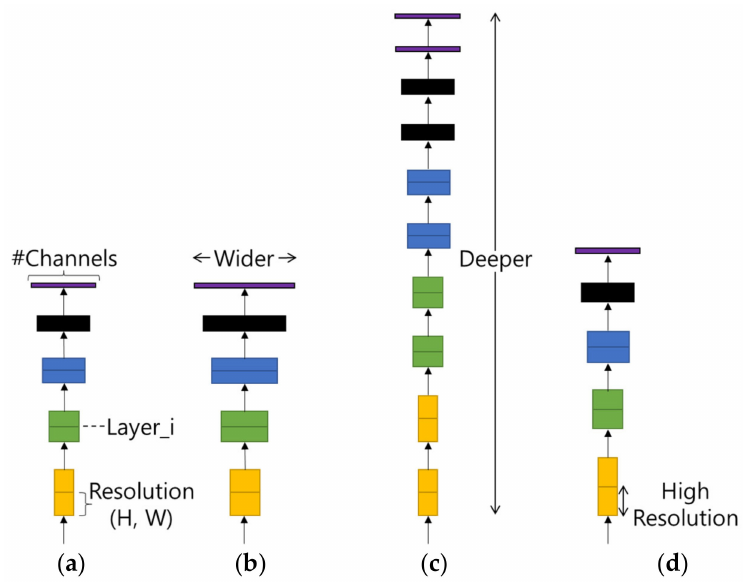
Table 4. Performance according to scale change in the same amount of computation. Model FLOPS Top-1 Acc Baseline model (EfficientNet-B0) 0.4B 77.3% Scale model by depth (d = 4) 1.8B 79.0% Scale model by width (w = 2) 1.8B 78.9% Scale model by resolution (r = 2) 1.9B 79.1% Compound Scale (d = 1.4,w = 1.2,r = 1.3)